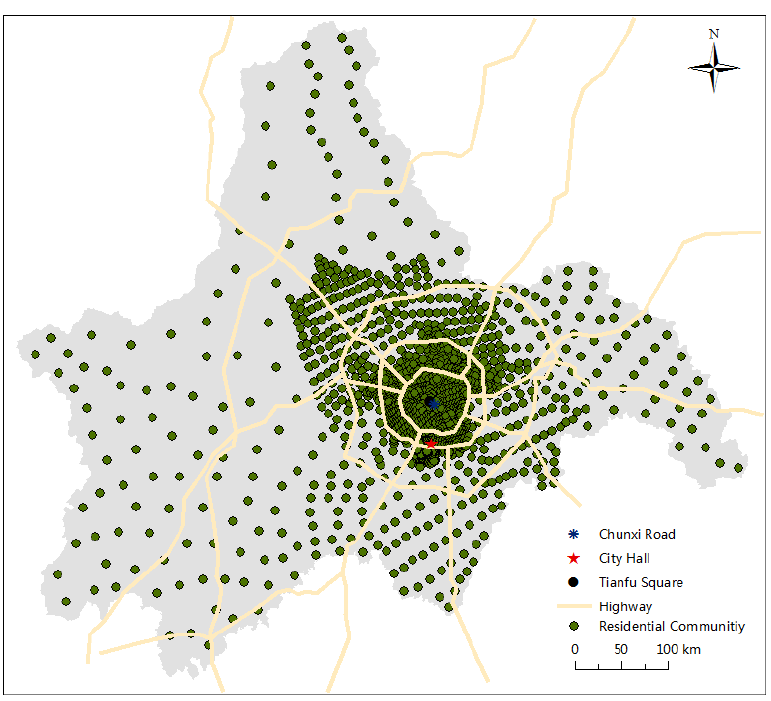
Figure 2. The distribution of residential communities. Data source: Chengdu ReallyDT Platform (www.reallydt.com).